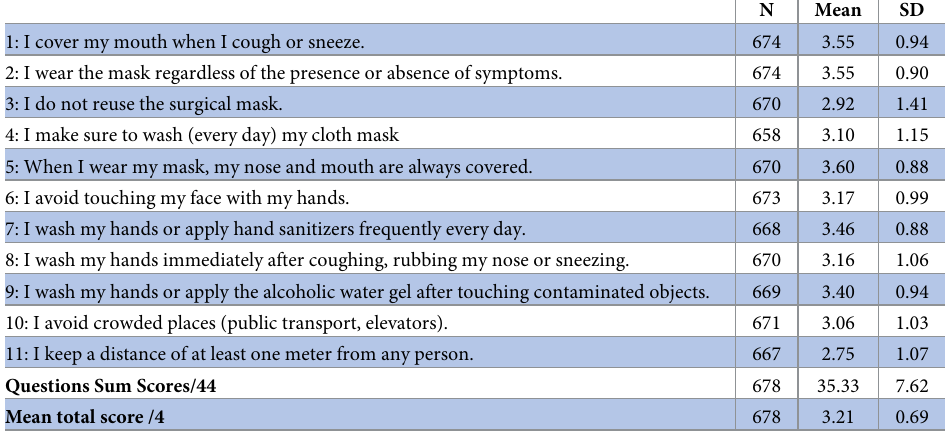
Table 2. Average scores of preventive practices among medical students at the medical school of Monastir.